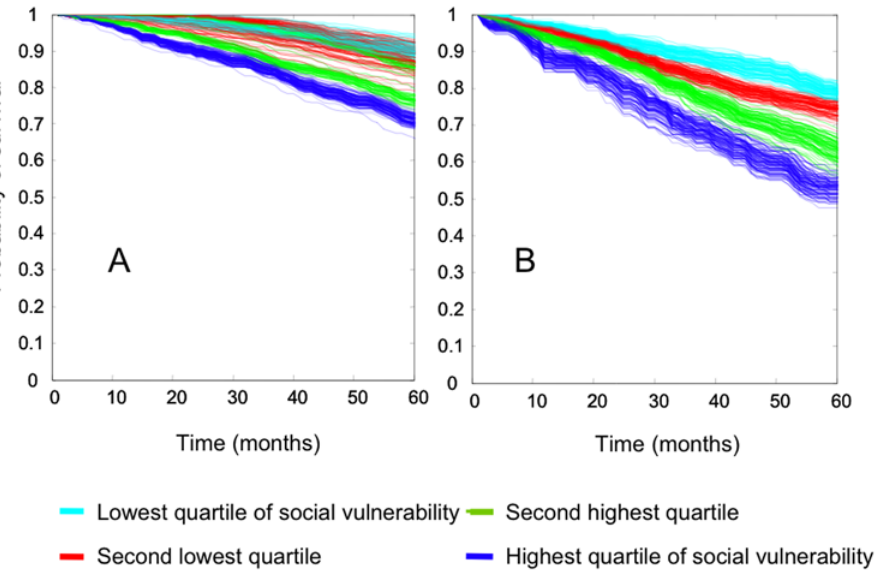
Figure 5. ‘Bootstrap by variables’ analyses. Survival curves show 100 replications of 80% re-sampling within the Canadian Study of Health and Aging social vulnerability index. Panel A – women, Panel B – men.